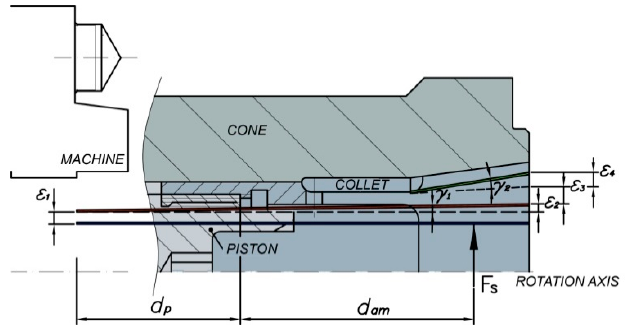
Figure 11. Deformation of collet chuck due to total clamping